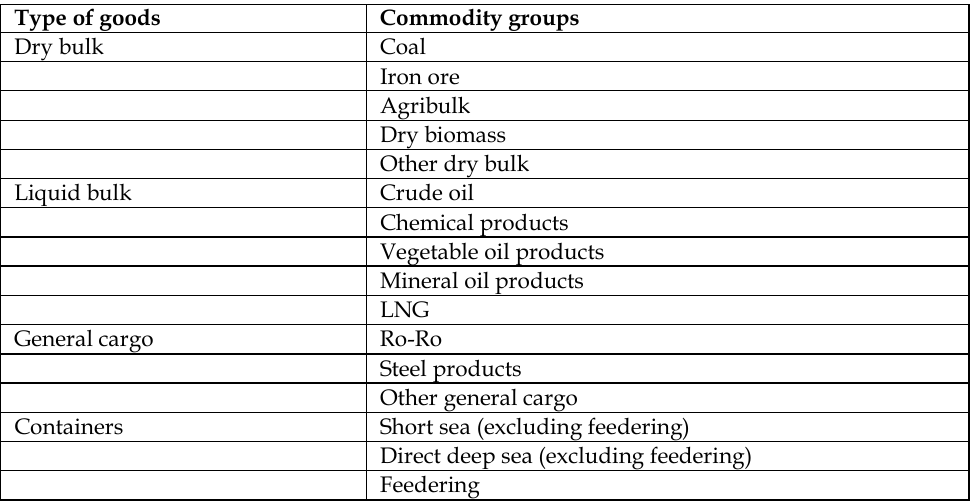
Table 2. Overview of commodity